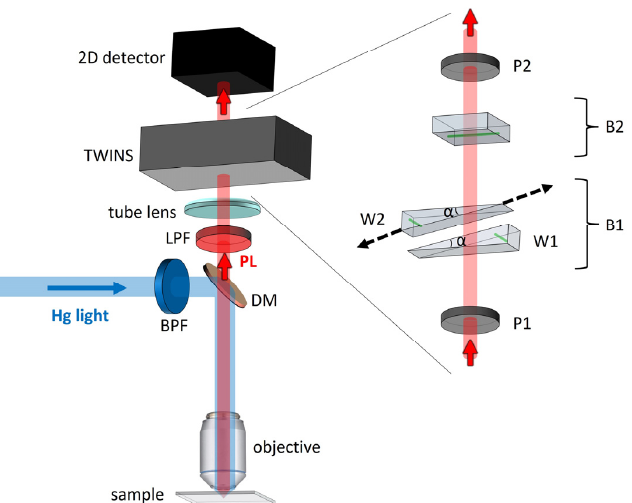
Figure 2. Scheme of the FT-HSM. Hg light: mercury lamp excitation light; PL: sample photoluminescence; LPF: low-pass filter; BPF: bandpass filter; DM: dichroic mirror; P1: first polarizer; B1: first YVO 4 block shaped into two wedges with apex angle α ; W1: fixed wedge; W2: translating wedge; B2: second YVO 4 block; P2: second polarizer. The black dashed arrows indicate the wedge W2 translation direction. The green lines indicate the YVO 4 crystal axis in the two wedges W1 and W2 of block B1 and in block B2.